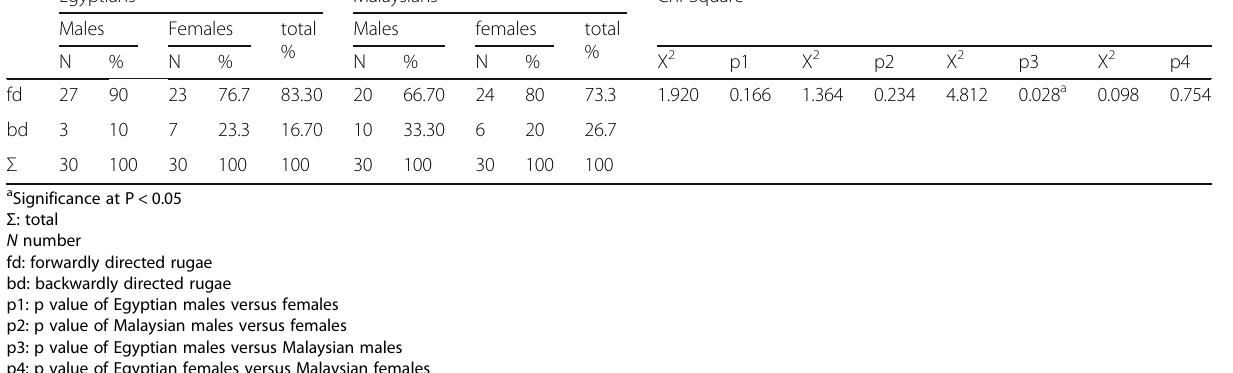
Table 2 Comparison of the predominant rugae direction among both sexes of Egyptians and Malaysians Egyptians Malaysians